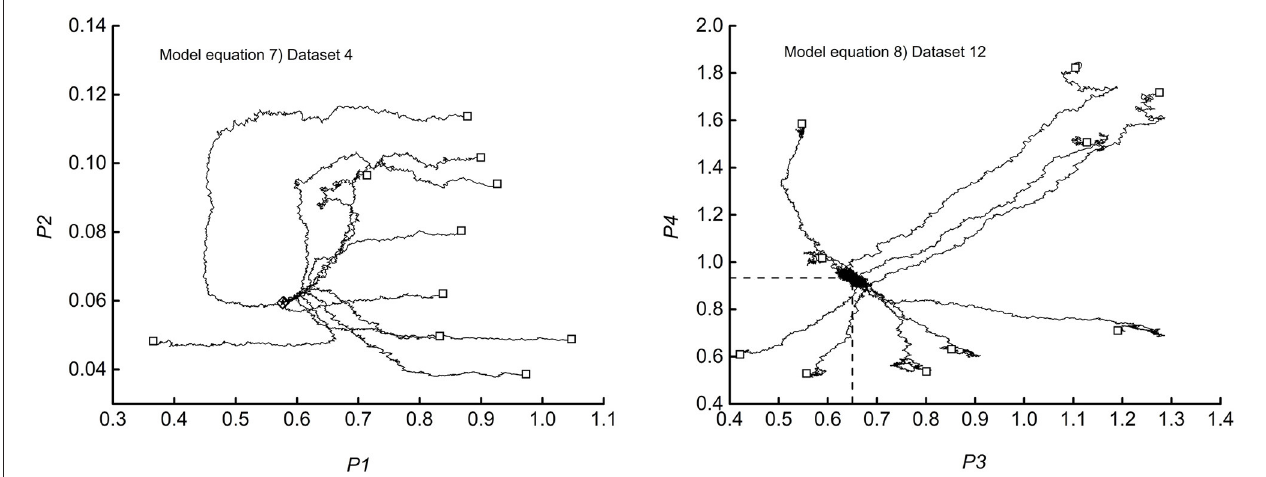
FIGURE 4 | Examples of random walks on the space parameter.